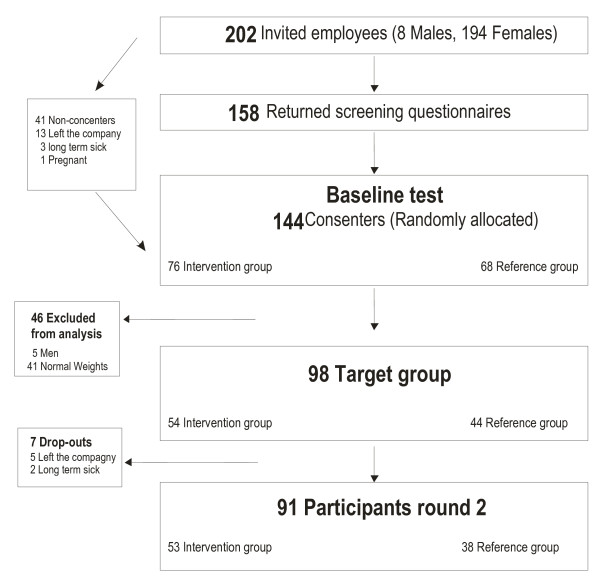
Flow of the participants.